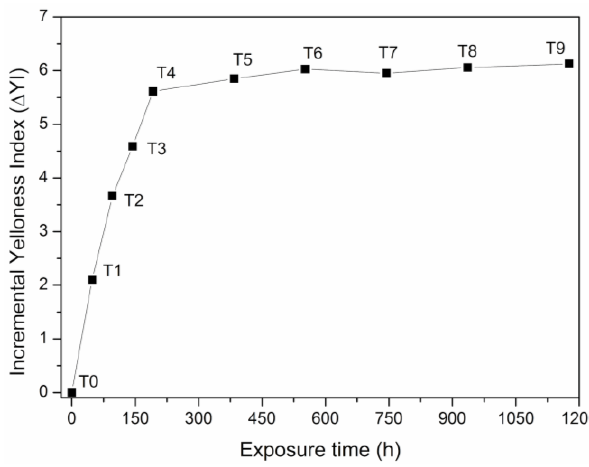
Figure 8. Incremental yellowness index (∆YI) versus UV exposure time of SEBS.